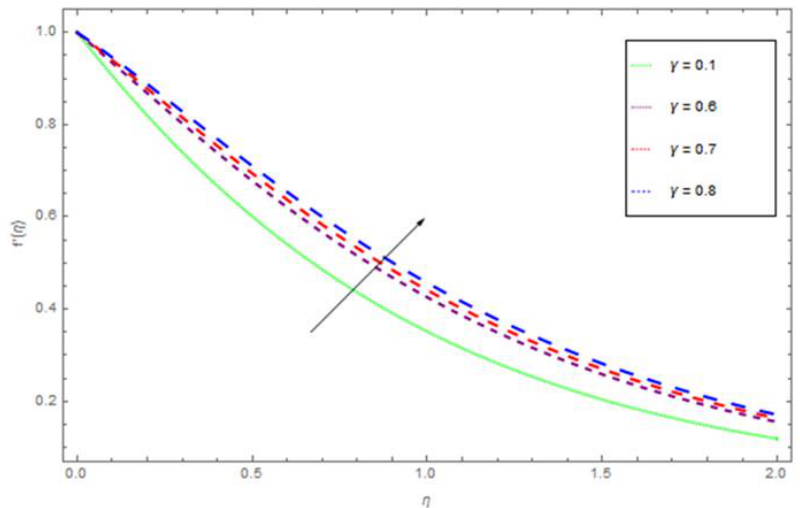
Figure 4. The influence of F on